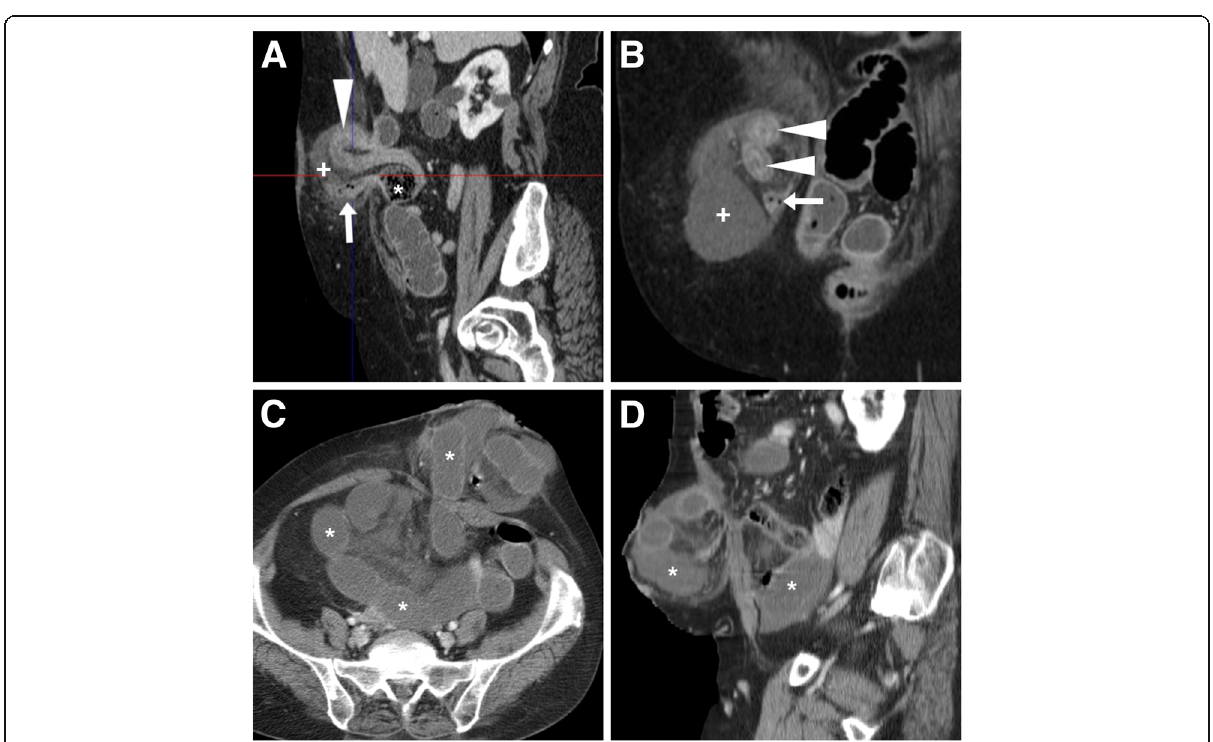
Fig. 15 Two surgically treated complications of PH. a , b Right-sided PH containing ileostomy tract (arrows) and another herniated small bowel (arrowheads) in a closed-loop obstructive pattern with markedly thickened walls and hypoenhancing submucosa, consistent with ischemia. c , d Strangulation with extensive small bowel infarction in a patient with PH at permanent colostomy: note dilated fluid-filled enteric loops (*), some of them with non-enhancing walls indicating